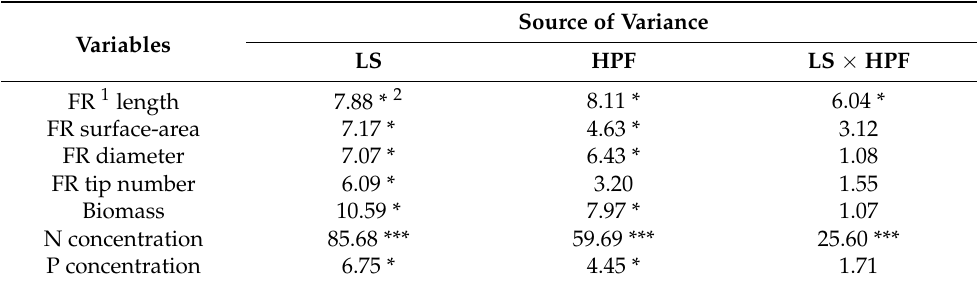
Table 3. F values from analysis of variance (ANOVA) of light spectra (LS), half-pot fertility (HPF), and their interaction (LS × HPF) on root morphology, biomass, and N and P concentrations and contents in Pinus pumila (Pall.) Regel